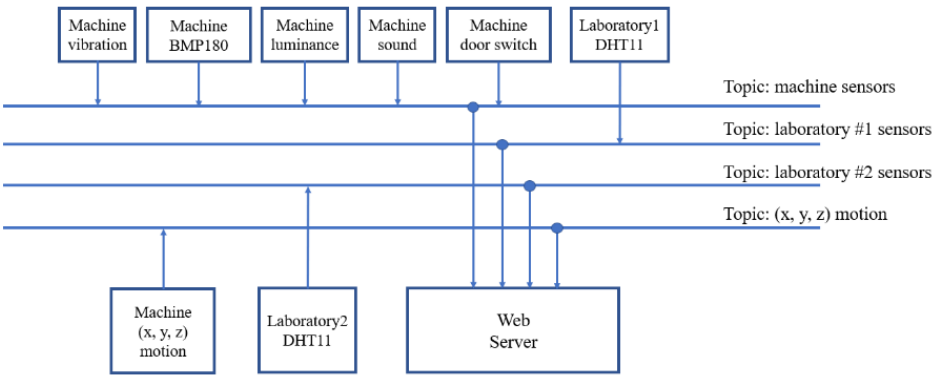
Figure 4. Subject flow diagram.